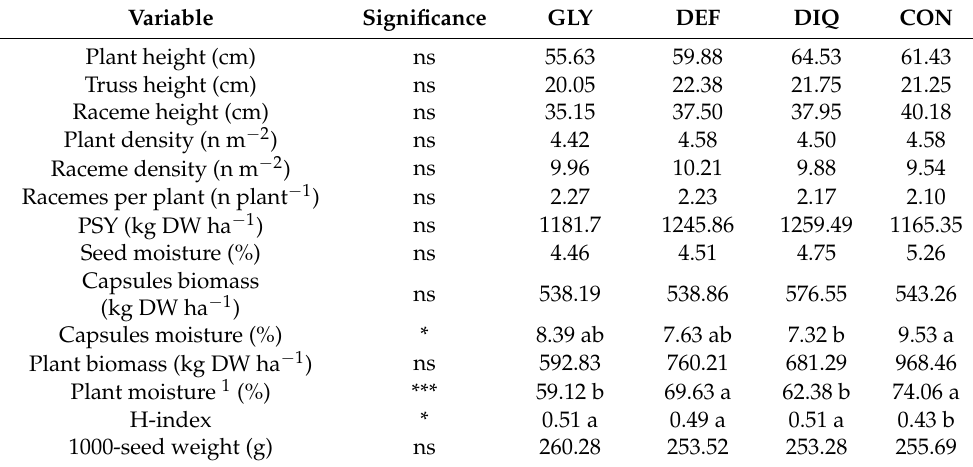
Table 1. Effects of Glyphosate, Spotlight and Diquat on hybrid Kaiima C1012: plant growth, aerial biomass production, seed yield, residual moisture in seeds, capsules and